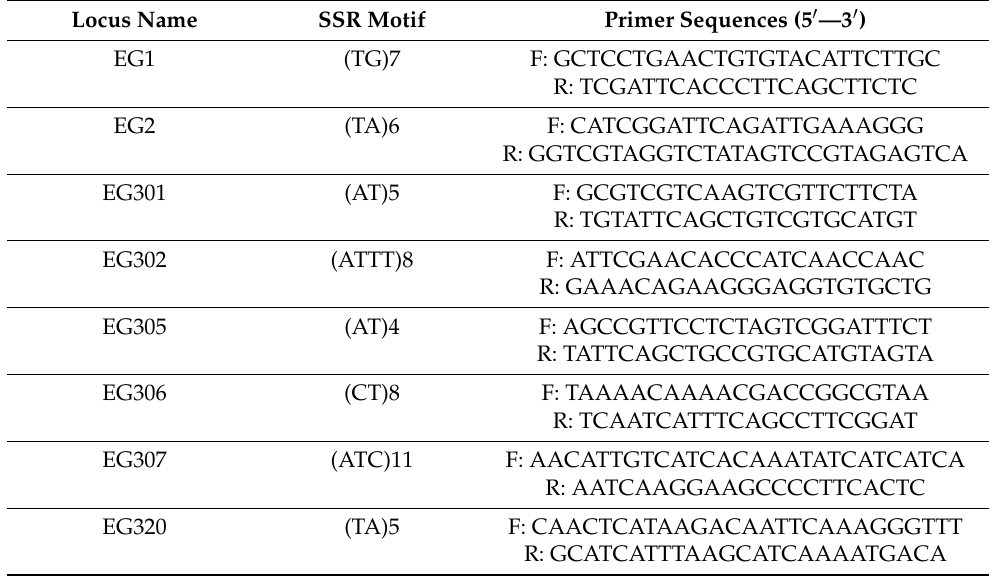
Table 1. Echinochloa crus-galli Simple Sequence Repeats. Locus name, motif, and primer sequences.